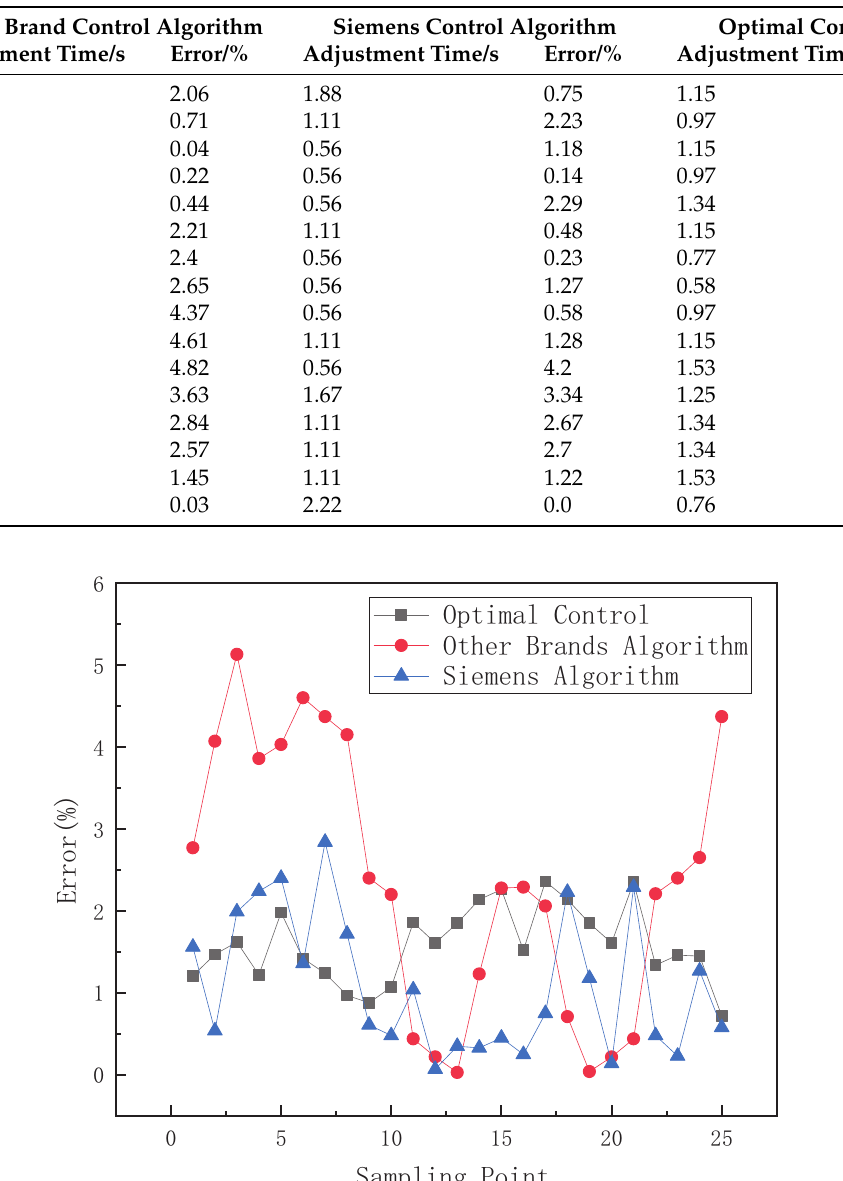
Table 2. Comparison of small-range exhaust control algorithms.